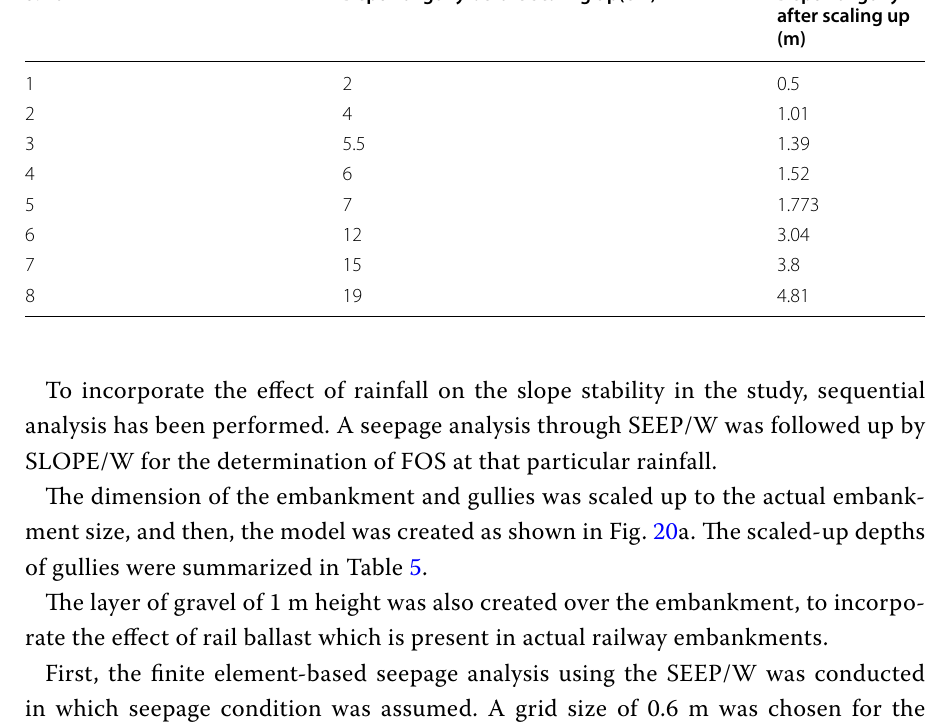
Table 5 Scaled up depth of gullies at RG1 and CG4 S.No Depth of gully before scaling up(cm) Depth of gully 2